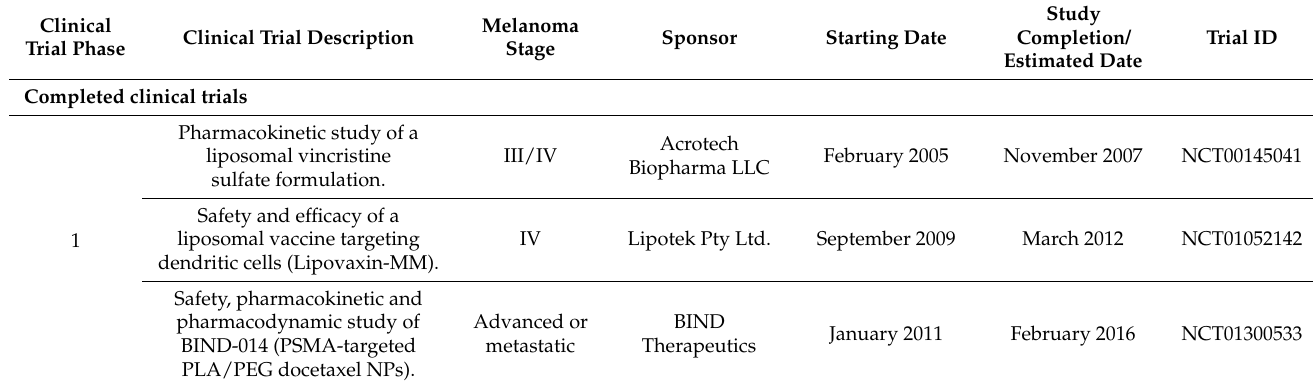
Table 8. Examples of the most representative (not all) clinical trials (completed or ongoing) using different types of nanosystems for melanoma